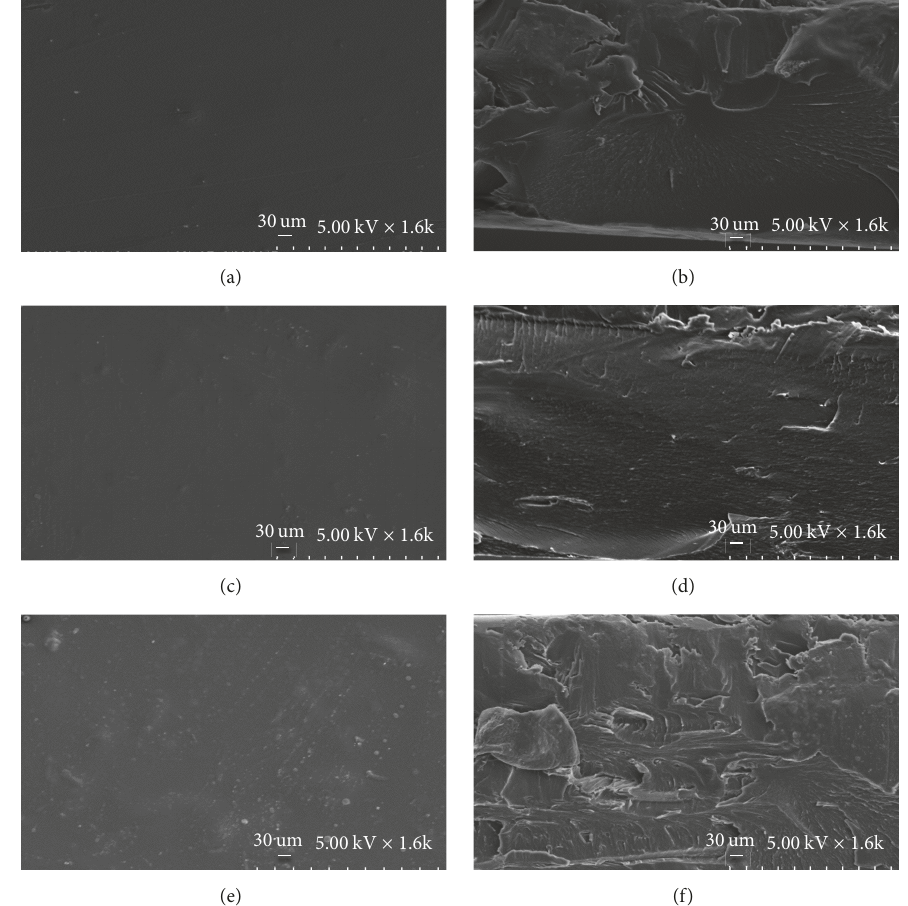
Figure 4: The SEM images of composite films F 0 (a, b), F 0.03 (c, d), and F 0.08 (e, f).